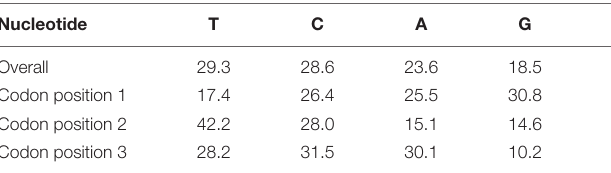
TABLE 2 | Nucleotide composition, overall, and order-wise GC content and GC at each codon position 1, 2, and 3. Nucleotide